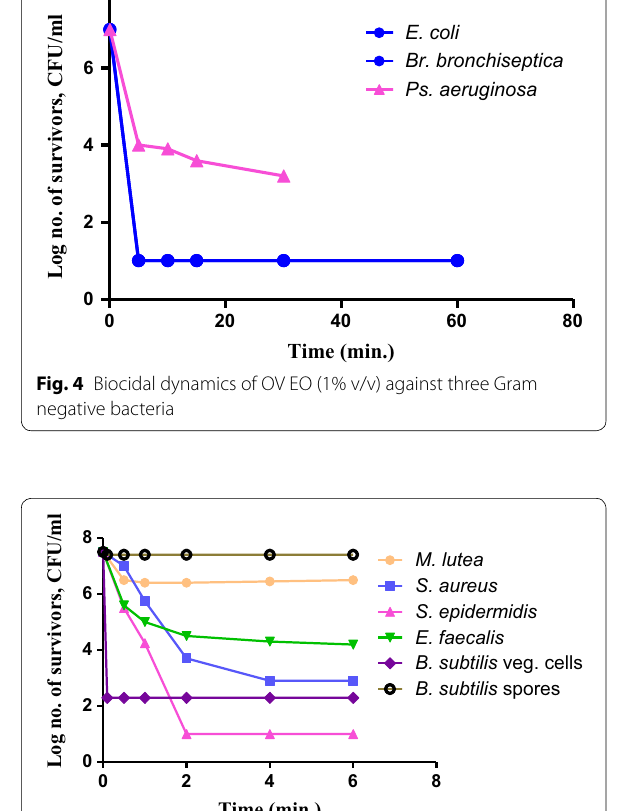
Fig. 5 Biocidal dynamics of OV EO (1% v/v) against three Gram positive bacteria